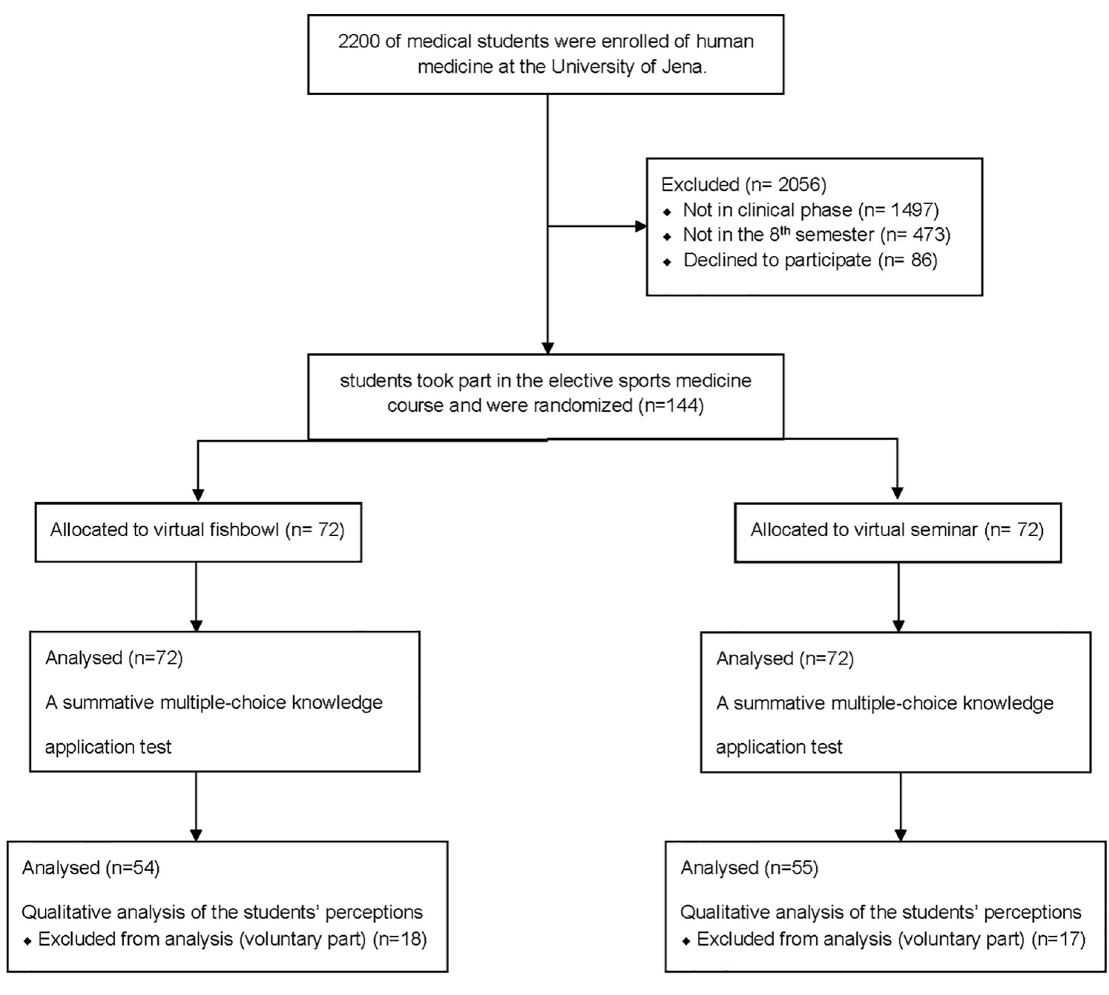
Fig 1. Schematic flow chart of the students’ enrollment